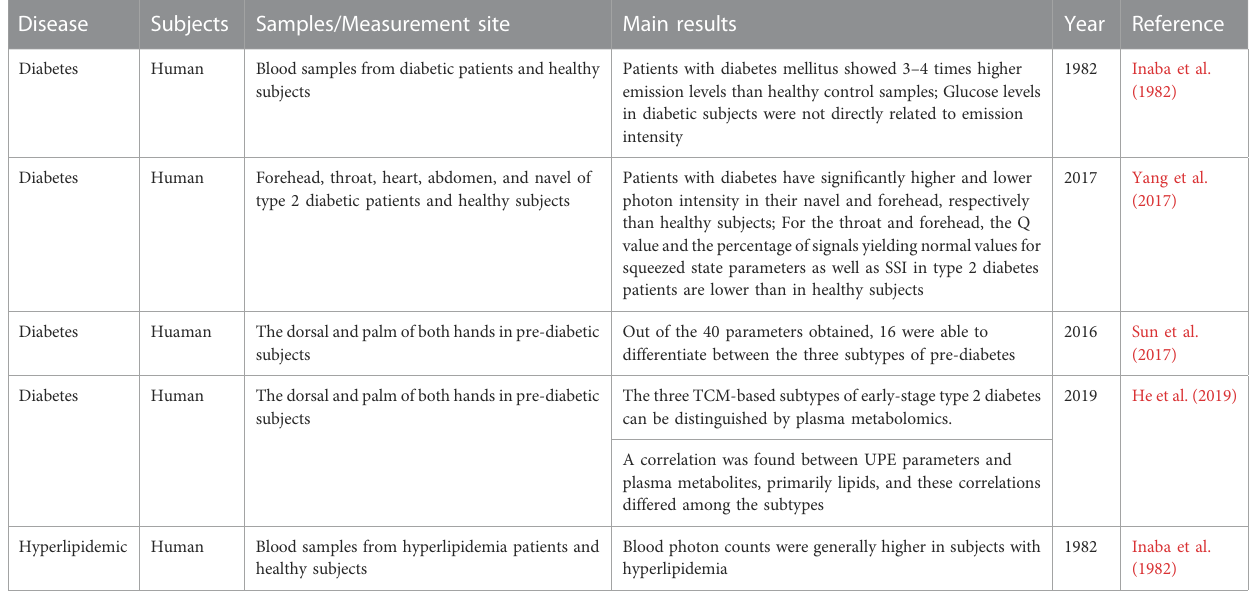
TABLE 2 Studies on the association between UPE and metabolic disorders.